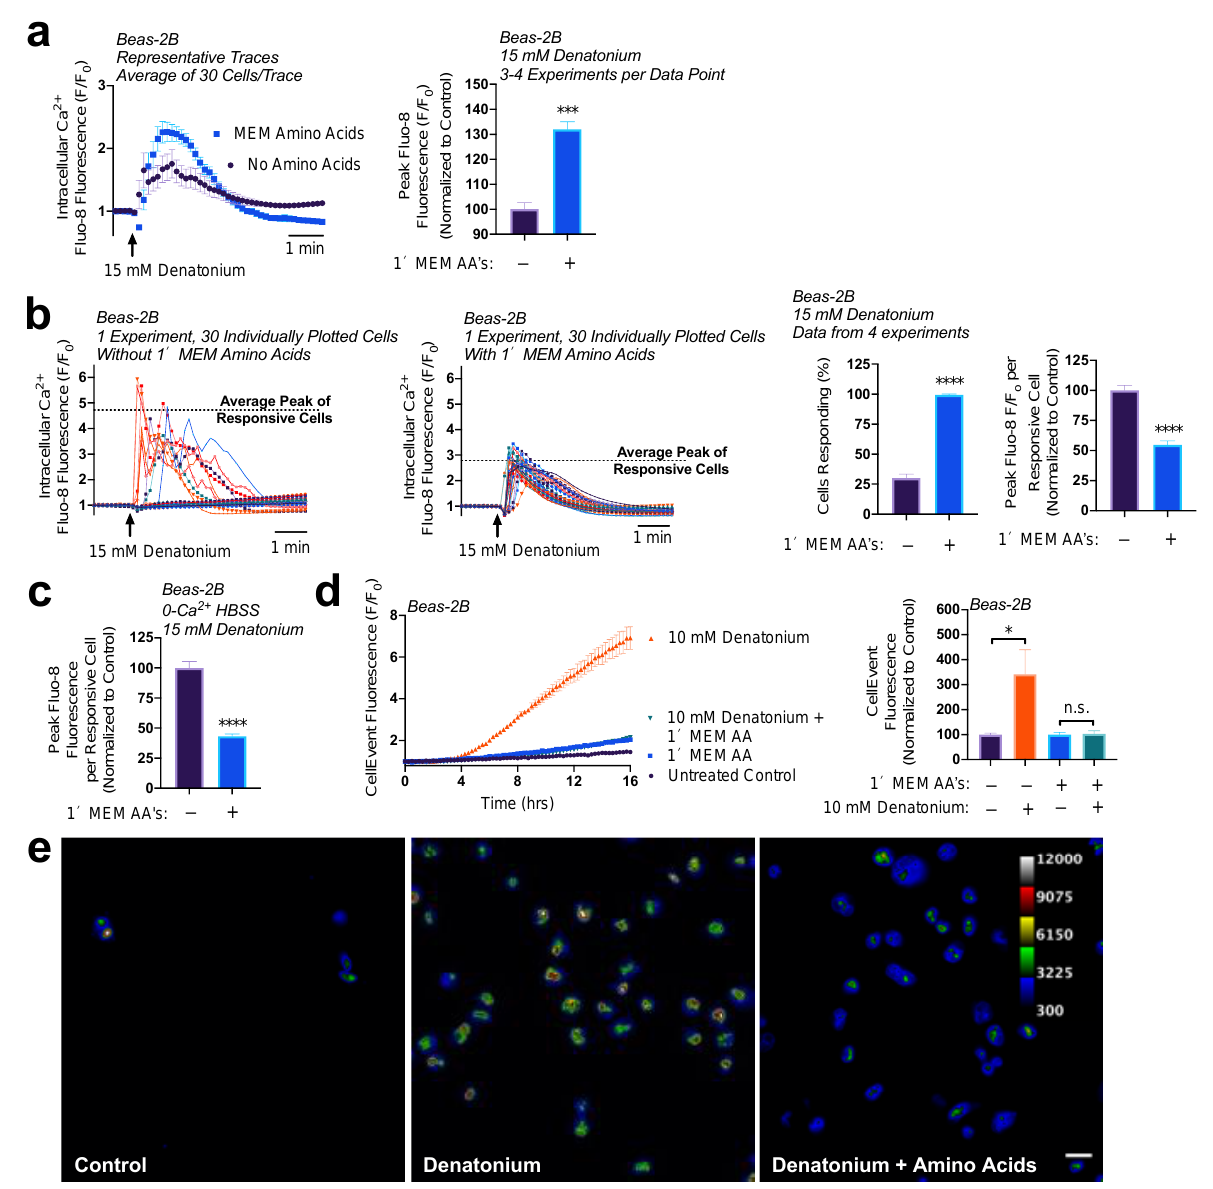
Figure 5. MEM amino acids reduce downstream denatonium-signaled caspase activity. ( a ) Pretreatment of Beas-2Bs with MEM amino acids caused a ~30% increase in denatonium-induced Ca 2+ elevations. ( b ) Closer analysis of data from ( a ) revealed that amino acid pretreatment increased the number of cells responsive to denatonium, but each cell had ~50% reduced peak Ca 2+ elevations relative to denatonium-treated cells in HBSS without amino acids. ( c ) Denatonium-induced Ca 2+ elevations originated from intracellular Ca 2+ stores in both the presence and absence of MEM amino acids. ( d ) 1× MEM amino acid treatment (1 h preincubation) blocked denatonium-signaled caspase activation as measured on a plate reader. ( e ) Cultures from experiments as in ( d ) visualized by microscopy revealed that some denatonium signaled caspase activity was still present, but significantly reduced. Traces are representative of ≥3 experiments. Bar graphs with only two comparison groups analyzed via t -test while bar graphs with >2 data comparison groups analyzed by ANOVA using Sidak’s post -test for paired comparisons: * p < 0.05, *** p < 0.001, **** p < 0.0001, “ n.s. ” represents no significance.